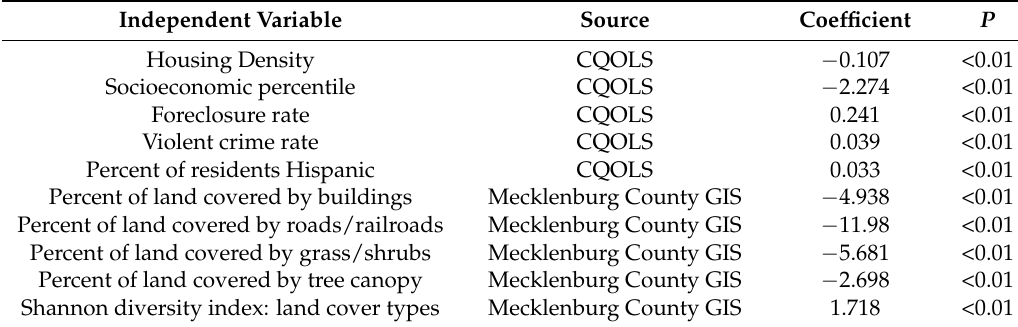
Table 4. Results of the second GLM predicting the abundance of gravid Ae. Albopictus .